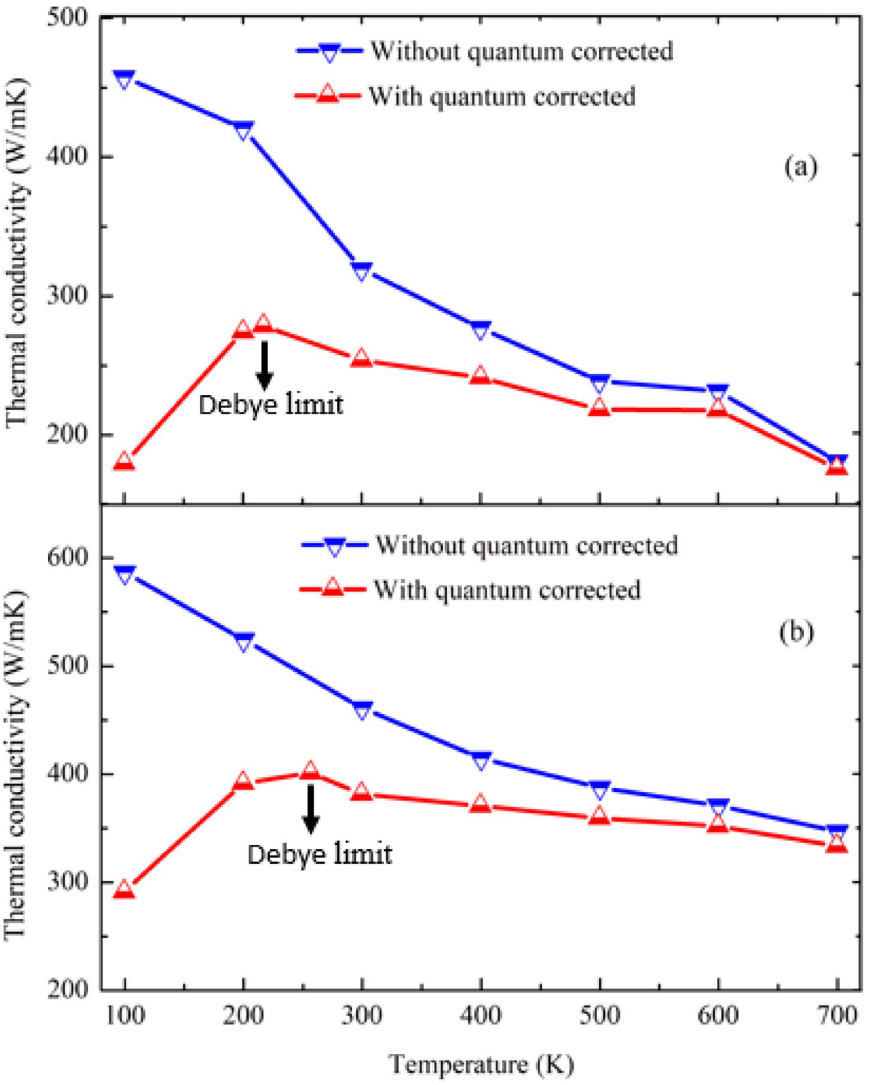
Figure 7. Quantum corrected thermal conductivity of the graphene/2D-SiC hetero-structure [( a ) original ( b )- optimized